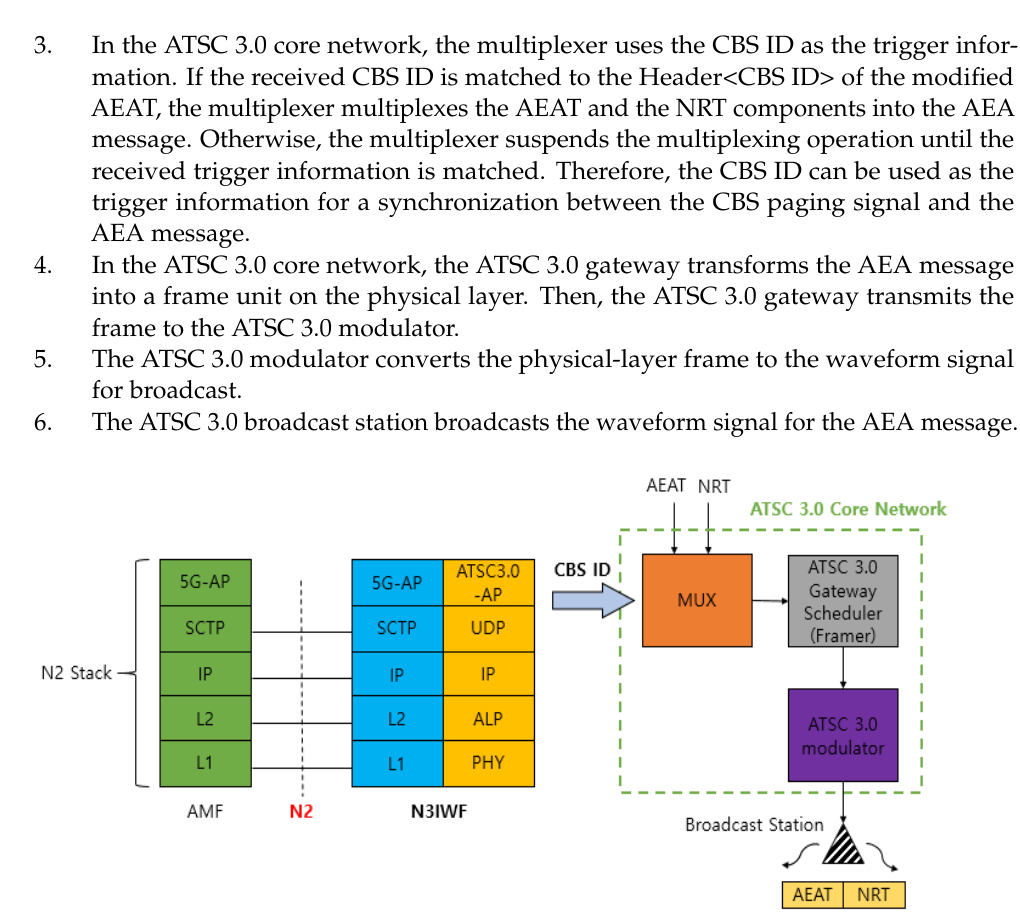
Figure 7. The specific framework for the interface between AMF and ATSC 3.0 core network using the N3IWF.